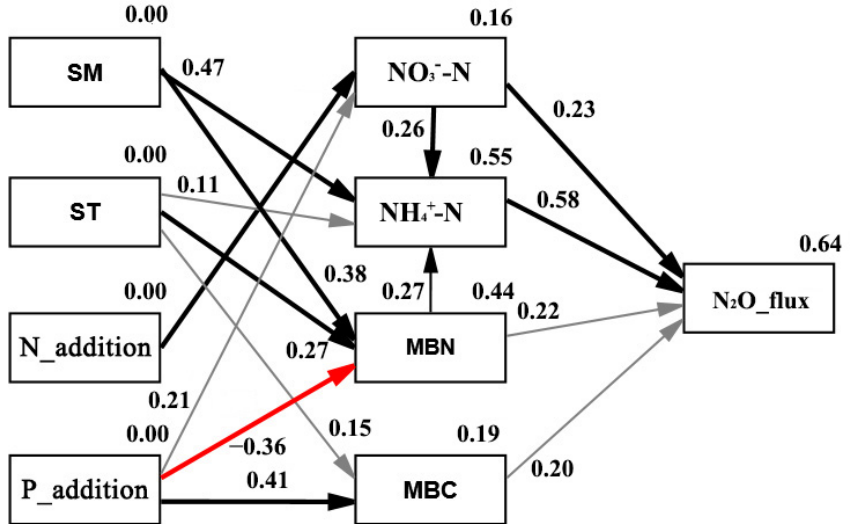
Figure 4. The structural equation model explaining the direct and indirect effects of N and P additions and soil properties on soil N 2 O fluxes across all treatments. SEM model parameters: χ 2 = 18.11, df = 18, RMSEA = 0.008 and GFI = 0.90. Black and wide arrows indicate significant positive relationships and red arrows indicate significant negative relationships ( p < 0.05). The thin and light-colored arrows indicated insignificant effects. Numbers on arrows are standardized path coefficients. The width of an arrow indicates the relative strength of the causal influence.